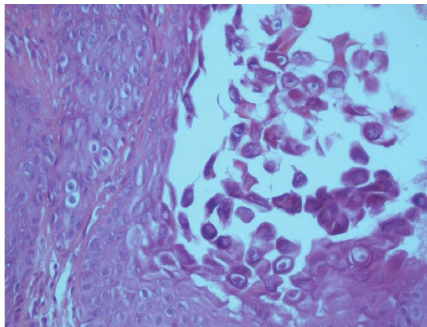
Figure 2: A group of dyskeratotic cells (corps ronds and grains) reflecting acantholysis and premature keratinization (200x,